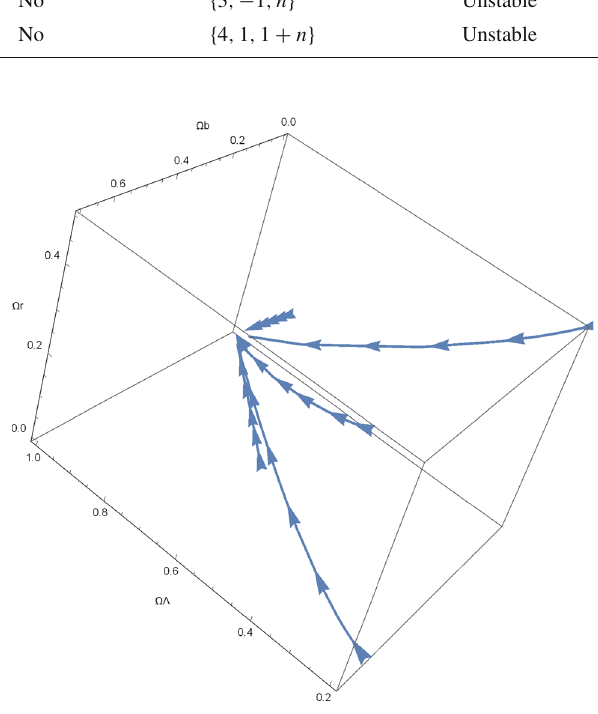
Fig. 3 Phase space diagram for the dynamical system (16), (17), (20). We consider (a) (cid:8) b = 0 . 2996 ,(cid:8) r = 0 . 0004, (cid:8) (cid:2) = 0 . 7, (b) (cid:8) b = 0 ,(cid:8) r = 0 . 1, (cid:8) (cid:2) = 0 . 9, (c) (cid:8) b = 0 . 3, (cid:8) r = 0 . 2, (cid:8) (cid:2) = 0 . 5, (d) (cid:8) = 0, (cid:8) = 0 . 5, (cid:8) (cid:2) = 0 . 2, (e) (cid:8) b r